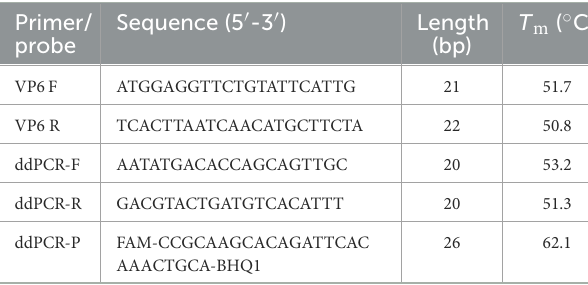
TABLE 1 Sequences of primers and probe for assays for